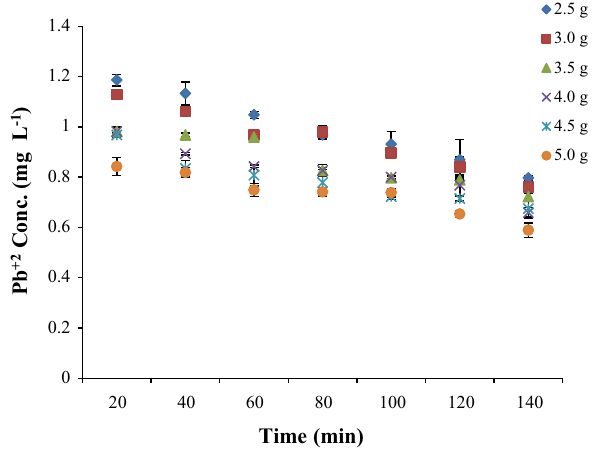
Fig. 6 Effect of time adsorbent dose and contact time lead (Pb 2+ ) concentration, at constant temperature (25 ± 3